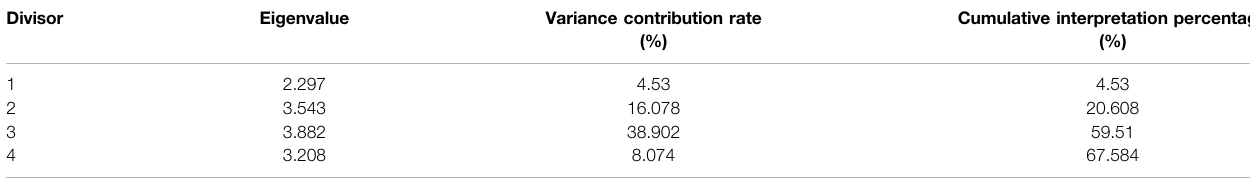
TABLE 5 | Factor analysis eigenvalues and variance contribution rate.